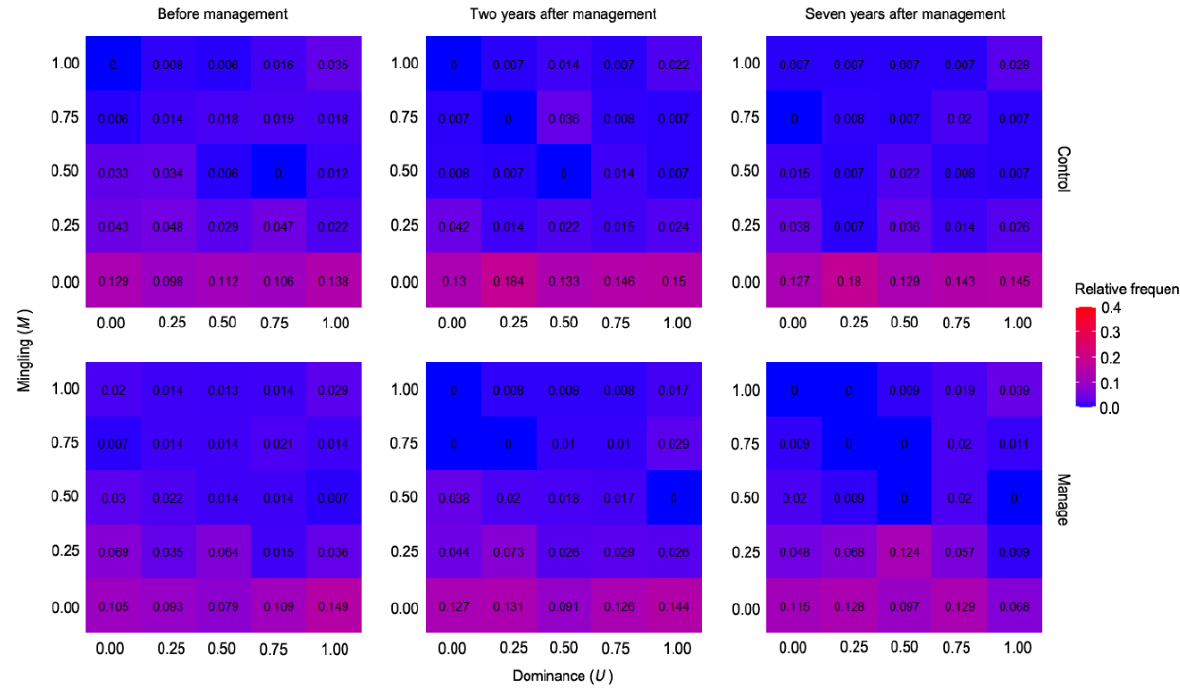
Figure 6. Bivariate distributions of 𝑈 and 𝑀 at different management years.